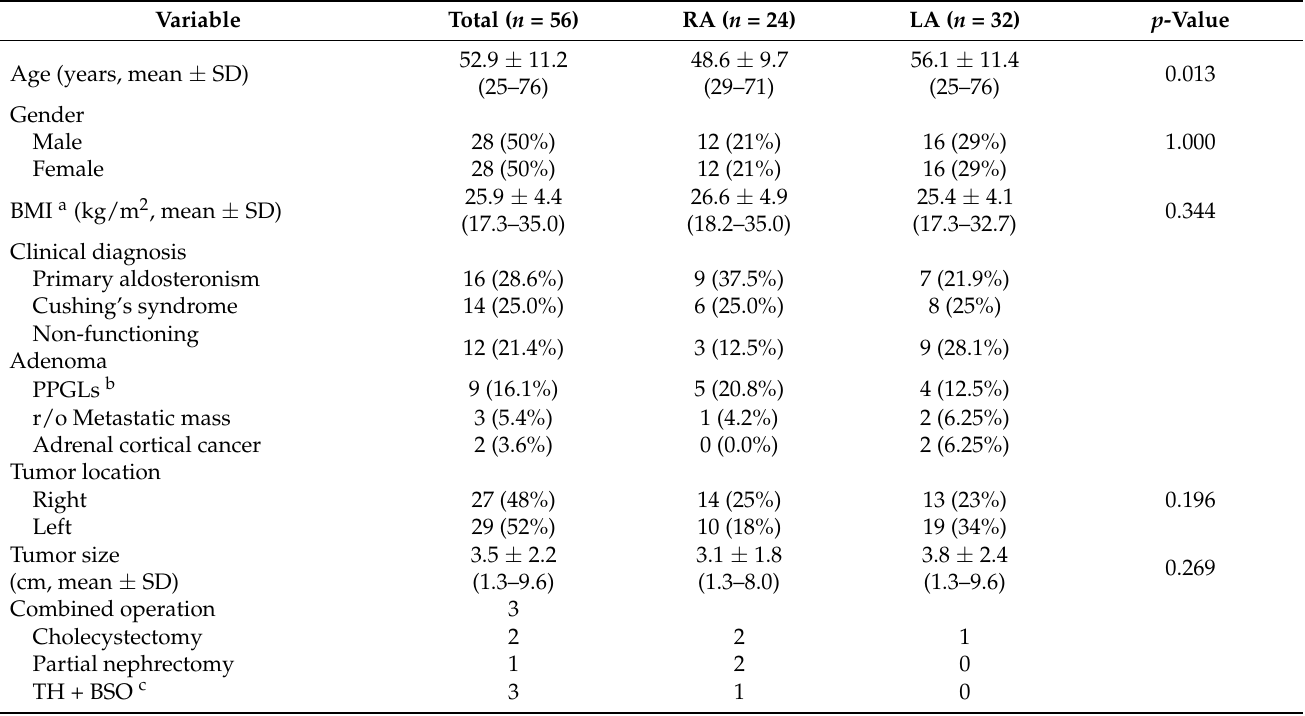
Table 1. Clinical characteristics of patients undergoing robotic adrenalectomy and laparoscopic adrenalectomy.